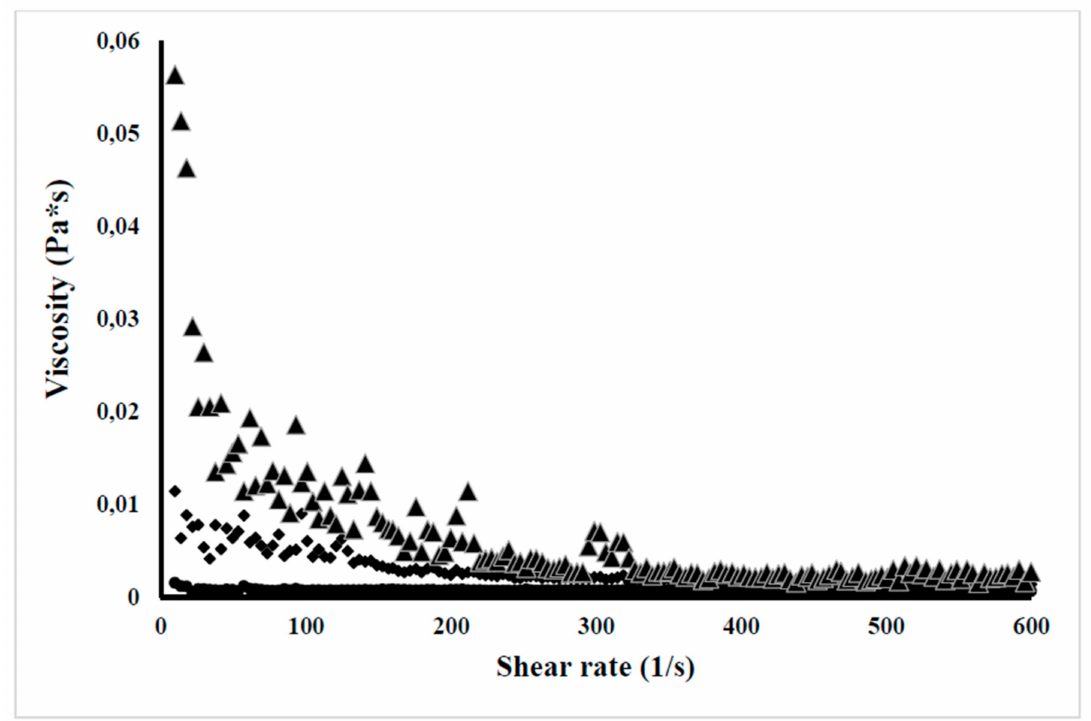
Figure 3. Viscosity dispersions of jackfruit seeds’ flour versus the shear rate at different concentrations ( • 1, (cid:7) 3, (cid:78) 5 g/100